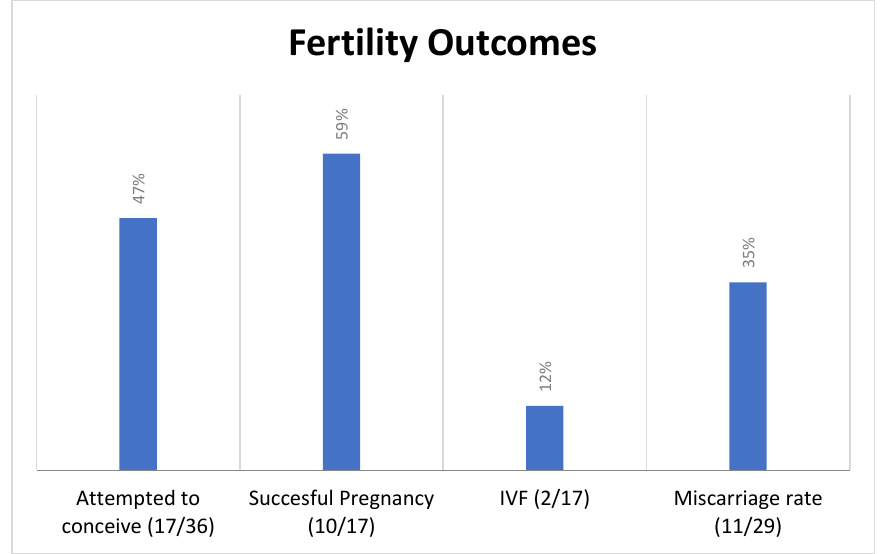
Figure 1. Fertility outcomes (%).